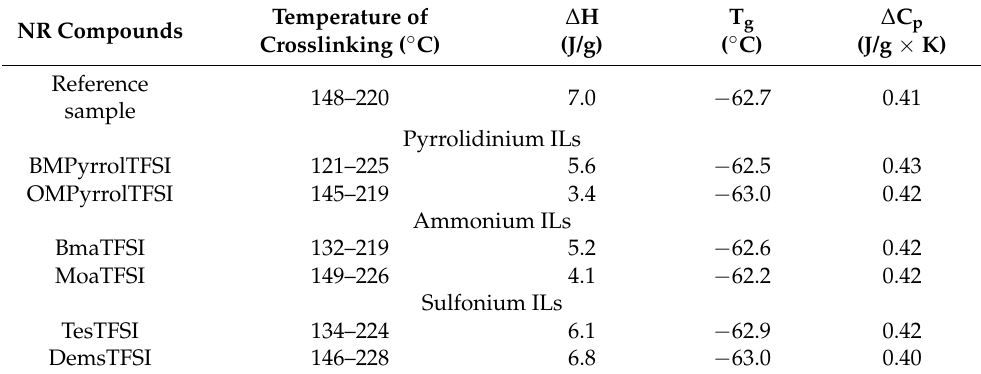
Figure 4. DSC curves of NR compounds containing sulfonium ILs with TFSI anion. Table 5. Temperature and enthalpy of crosslinking reactions measured by differential scanning calorimetry (DSC) for NR compounds containing ILs with TFSI anion ( ∆ H, enthalpy of crosslinking; T g , glass transition temperature; ∆ C p, heat capacity; SD: temperature ± 9.0 ◦ C; ∆ H ± 2.6 J/g; T g ± 1 ◦ C; ∆ C p ± 0.1 J/g ×